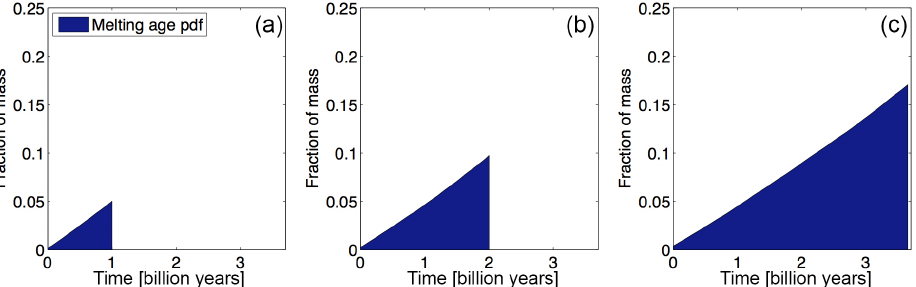
Figure 6. Cumulative probability density functions of the distribution of melting ages at different times during the calculation. The “fraction of mass” indicated on the vertical axes is the fraction of the total mass of the mantle. (a) 1 billion years; (b) 2 billion years; and (c) 3.6 billion years. Time is plotted as “calculation time”, meaning that 3.6 billion years is present day and 0 is 3.6 billion years in the past. Images are based on 40 bins. The gradual increase in total fraction of mantle mass that has a melting age matches the steady melt production rate (Fig. 5c). Towards the end of the calculation close to 20% of the volume of the mantle has been through melting at least once.